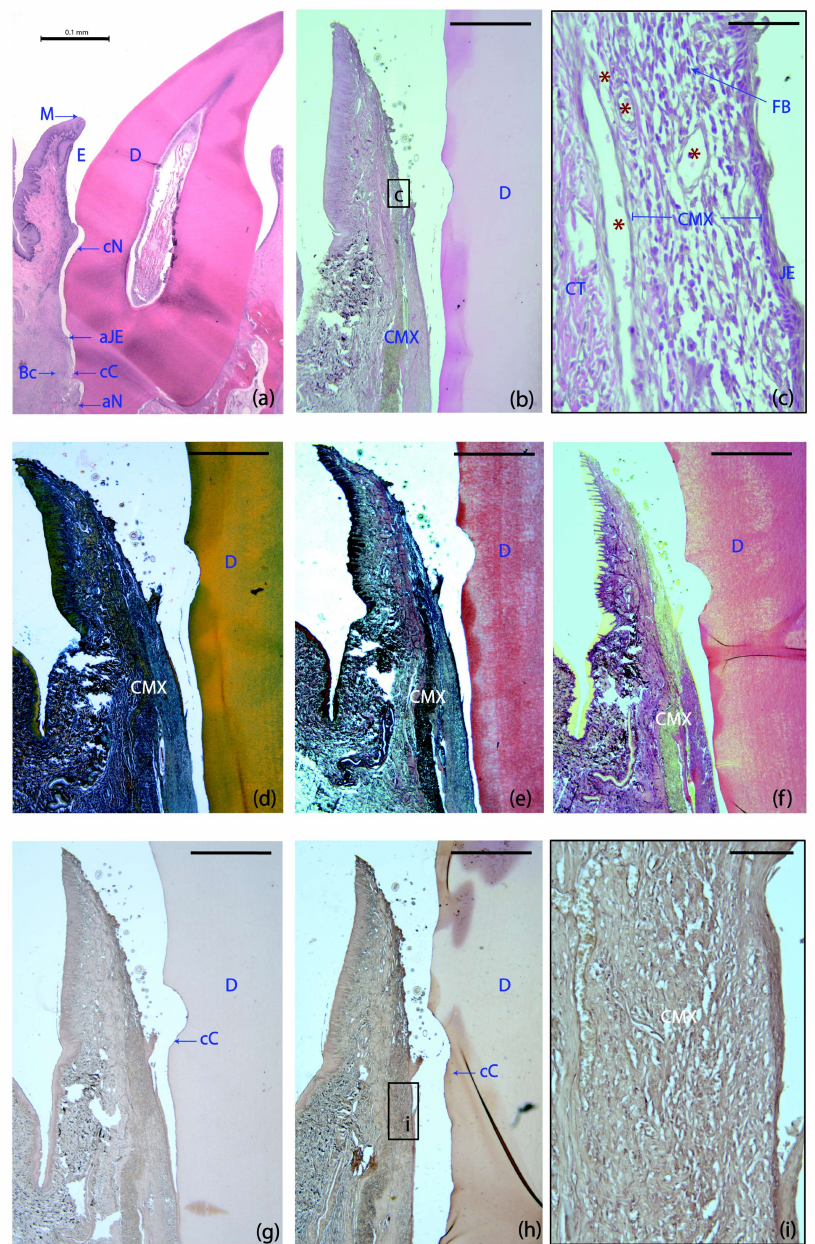
Figure 3. Histological landmarks and histology slides of a tooth allocated to the GMSCs group at six weeks. ( a ) Landmarks used for histometric analysis; haematoxylin and eosin (HE) stain. ( b ) Cross-section of the buccal dento-gingival region; HE stain. ( c ) High-magnification images of the gingival area containing the matrix. ( d ) Masson’s trichrome stain. ( e ) Movat’s pentachrome stain. ( f ) Picrosirius red stain. ( g – i ) Immunohistochemistry for green fluorescent protein (GFP): control ( g ) and GFP-labeled samples ( h ). ( i ) High magnification image of the GFP-labeled sample. Note the different color intensity among the control and the GFP-labeled groups, demonstrating the influence of GFP + cells on the formation of new periodontal tissues. M, the most coronal marginal mucosa; aJE, the most apical extent of the junctional epithelium; cC, the most coronal extent of the cementum; cN, the most apical portion of the coronal notch at the level of the gingival margin; aN, the most apical portion of the apical notch; Bc, the most coronal level of the bone crest; E; area where the enamel was before decalcification; D, dentin; CMX, collagen matrix; JE, junctional epithelium; CT, connective; FBs, fibroblasts; red asterisks, blood vessels. Scale bar = 0.1 mm ( a ); 1000 µ m ( b – g ); 50 µ m ( c ); 100 µ m ( i